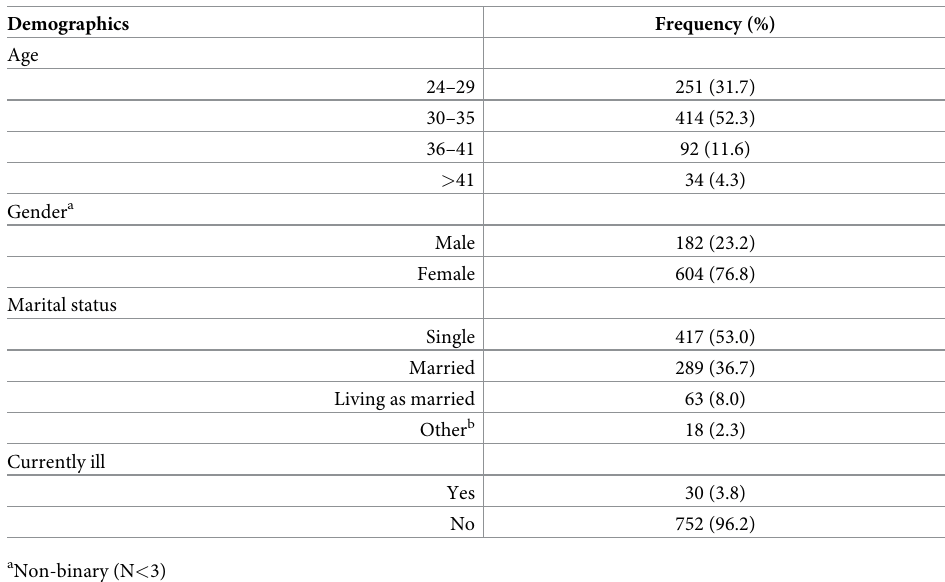
Table 2. Descriptive statistics of the demographic variables of the study